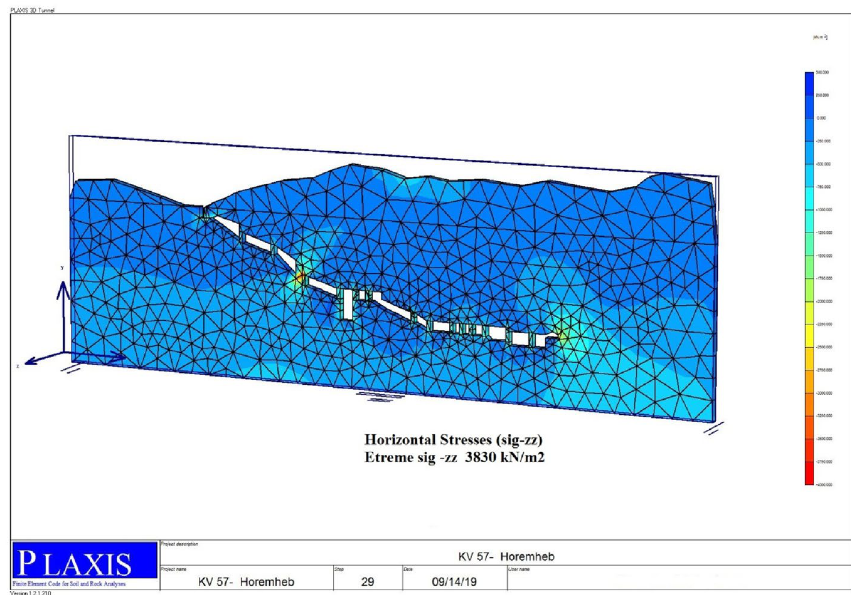
Fig. 5. Horizontal stresses sig –zz, the extreme value is 3.83